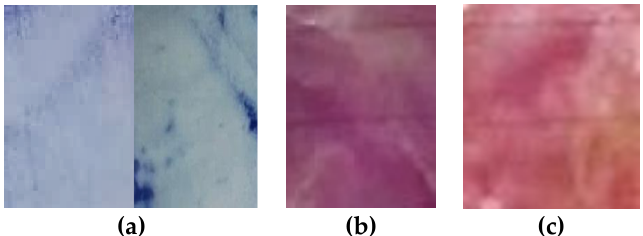
and ( c ) at 71.1 °C .